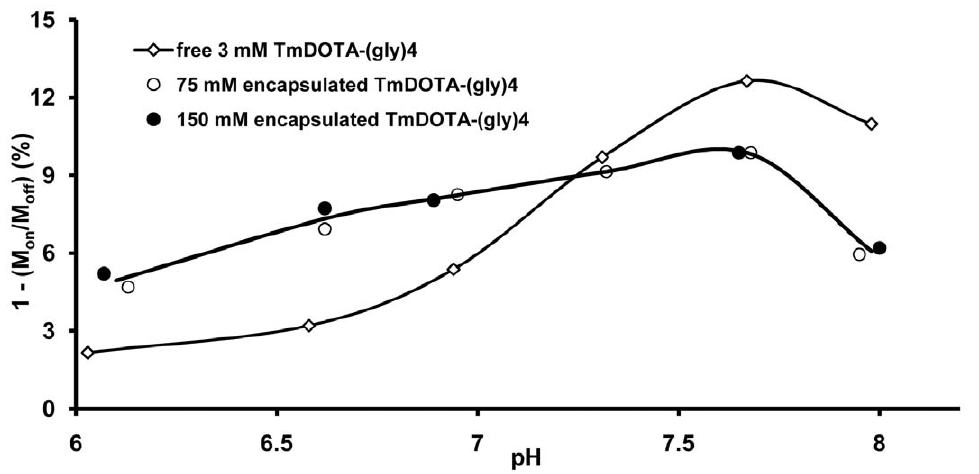
Figure 9. Comparison of amide proton CEST intensities versus pH for free and liposome-encapsulated TmDOTA-(gly) 4 2 . The amide proton CEST intensity for free TmDOTA-(gly) 4 2 sample (3 mM, no lipid, same data as that shown in Fig. 8) and liposomal-encapsulated TmDOTA- (gly) 4 2 (intraliposomal concentrations of 75 mM and 150 mM) were measured as a function of pH at 9.4 T and 310 K using a B 1 =7.0 m T and a presaturation time of 6 s. The number of liposomes in the later two samples was adjusted so that the total concentration of TmDOTA-(gly) 4 2 in each sample was 3 mM when averaged over the entire volume.